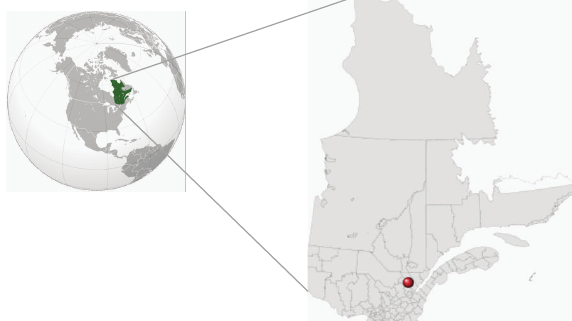
Figure 1: Location of the Montmorency Forest within the province of Quebec